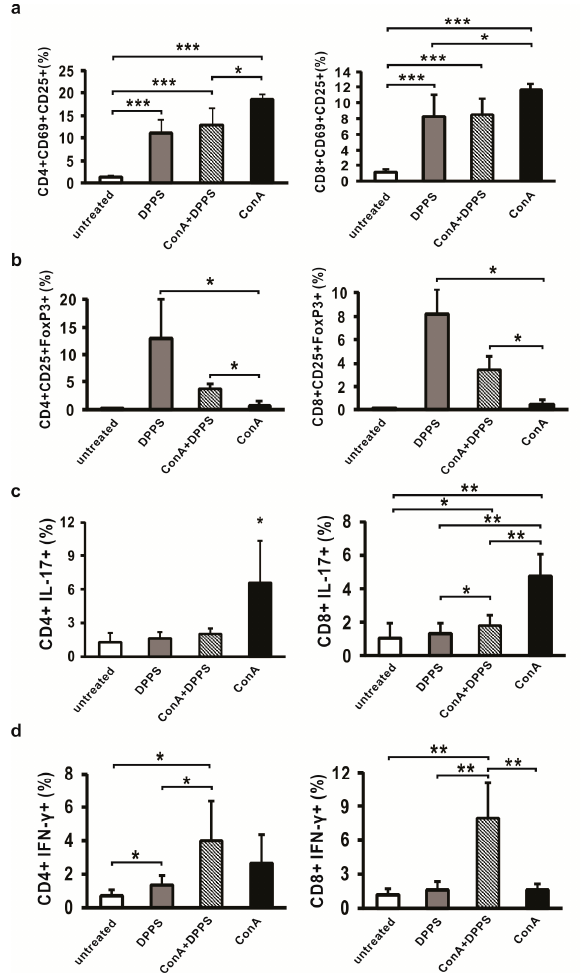
Figure 6. Effects of DPPS on phenotype of lymphocytes in the livers of ConA-treated mice. Percent- ages of activated CD25+CD69+ ( a ), regulatory CD25+FoxP3+ ( b ), IL-17+ ( c ) and IFN- γ + ( d ) CD4+ and CD8+ cells determined by flow cytometry of mononuclear cells isolated from the livers 12 h after ConA injection ( n = 6). Data are presented as mean + SD (*** p < 0.001; ** p < 0.005; * p <